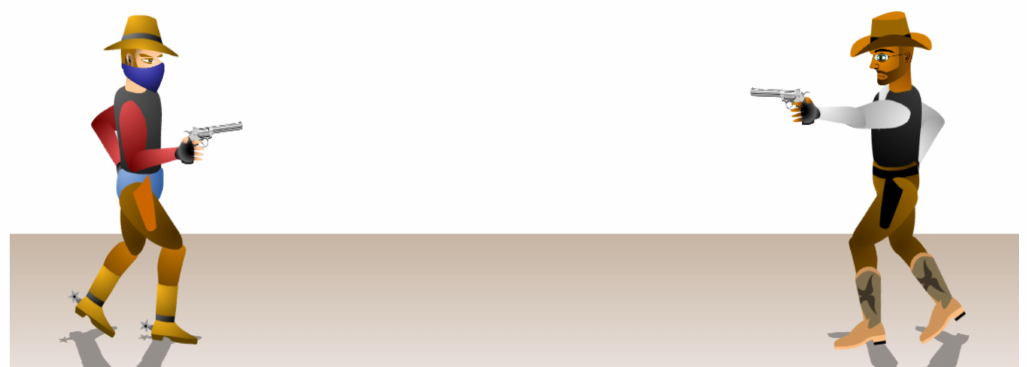
Figure 1. Stochastic duel